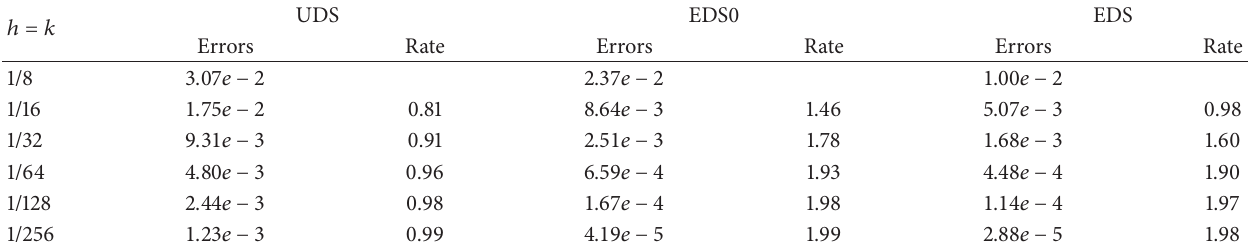
Table 3: Maximum absolute errors and rate of convergence, Example 8 with 𝑃 = 100 .